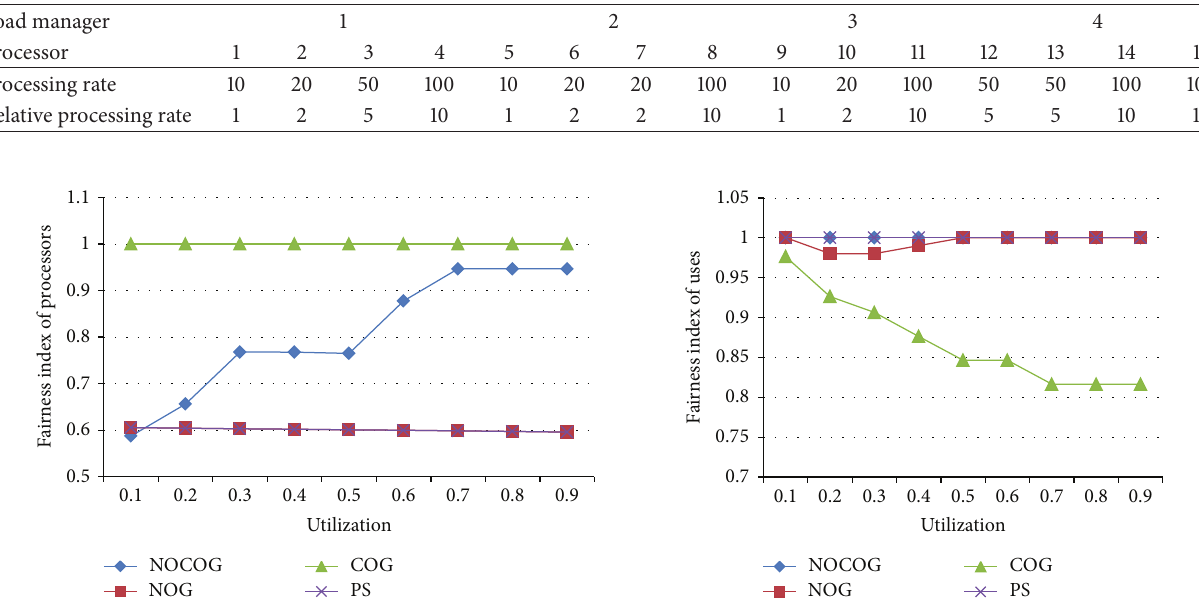
Table 1: Configure information of computing center.